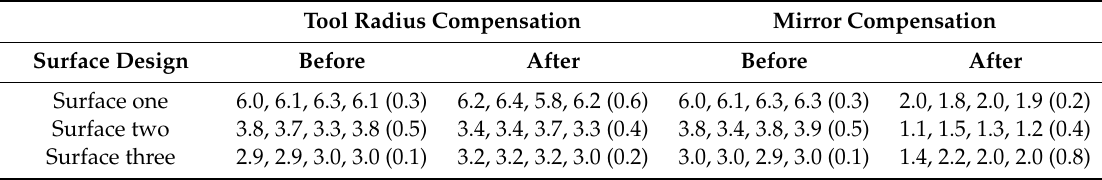
Table 2. Standard deviations of the errors of the four replicas for the three surfaces by using tool radius compensation or mirror compensation. Each of the values within the parentheses represents the range of the four values above it. Unit: µ